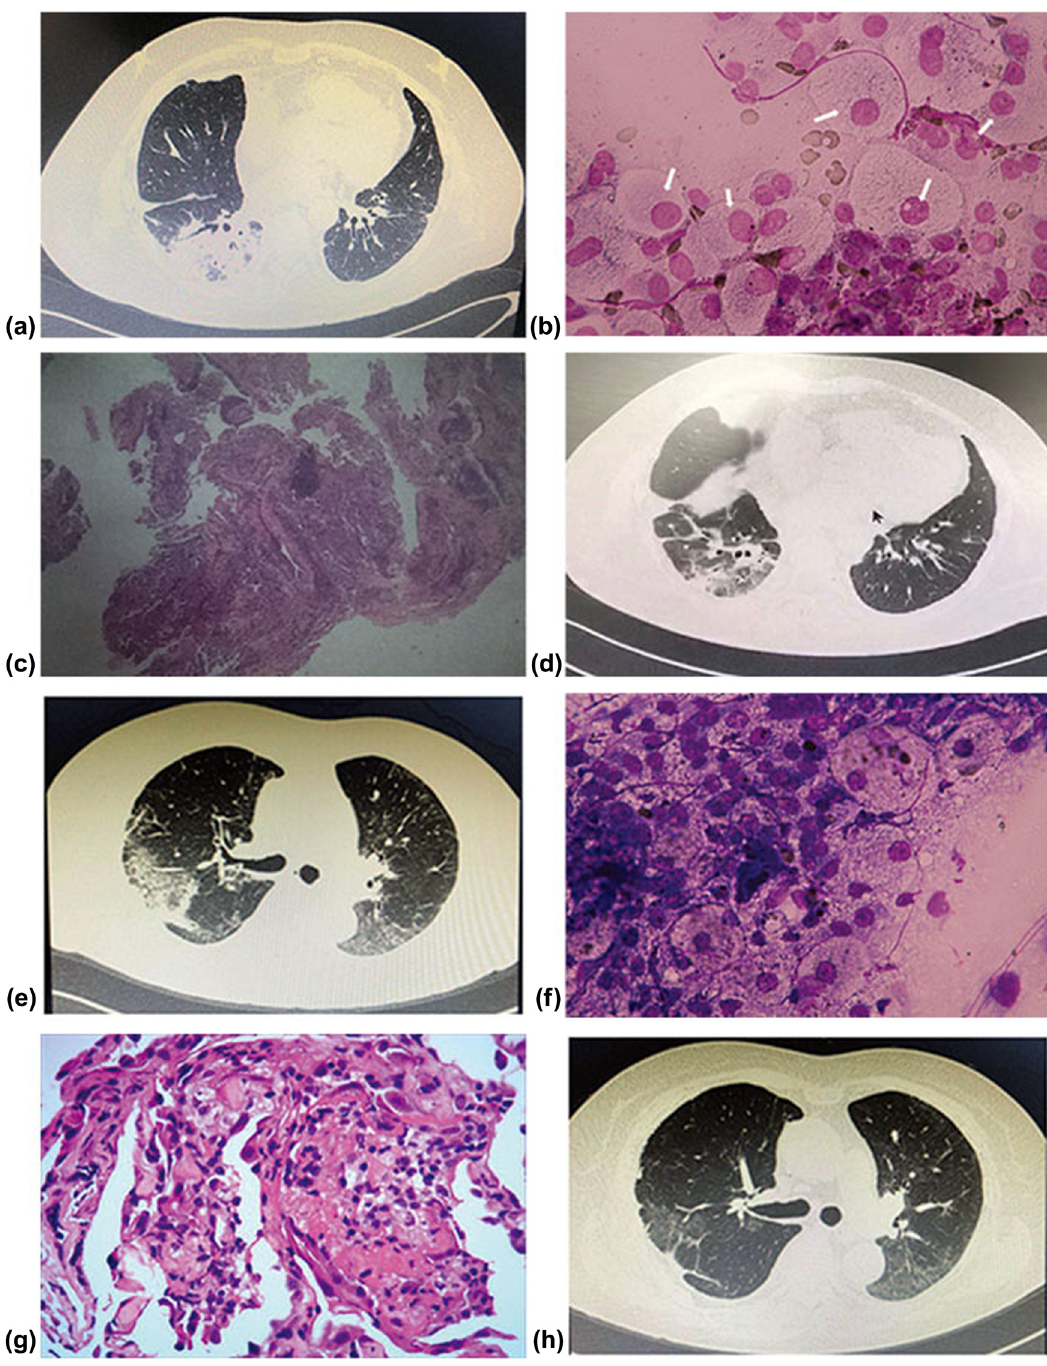
Figure 4: CT, ROSE, and histologic fi ndings of case 6 and